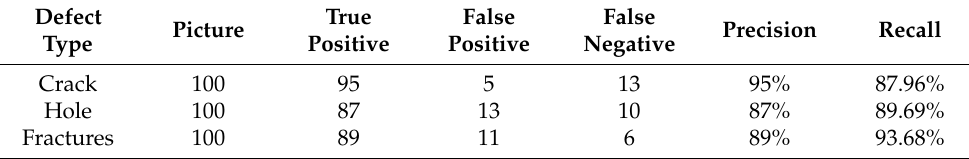
Table 3. CNN defect classification